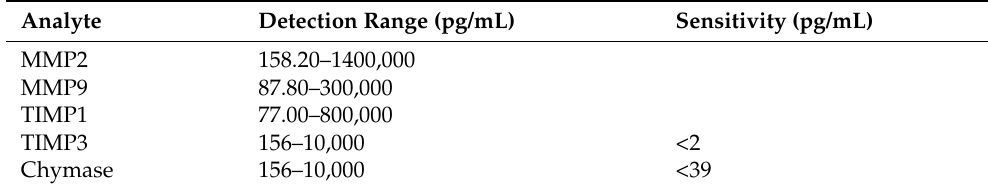
Table 3. Assay detection